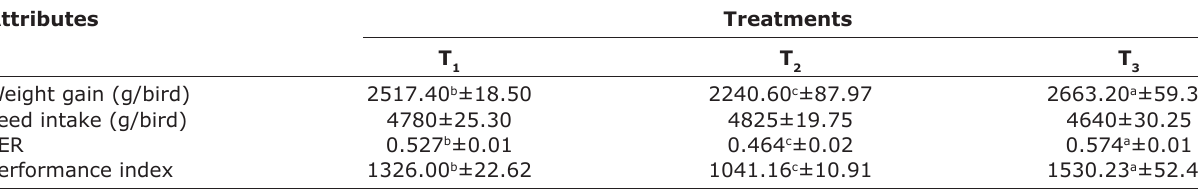
Table-2: Performance of broilers as influenced by multicarbohydrases supplementation (0-6 weeks).